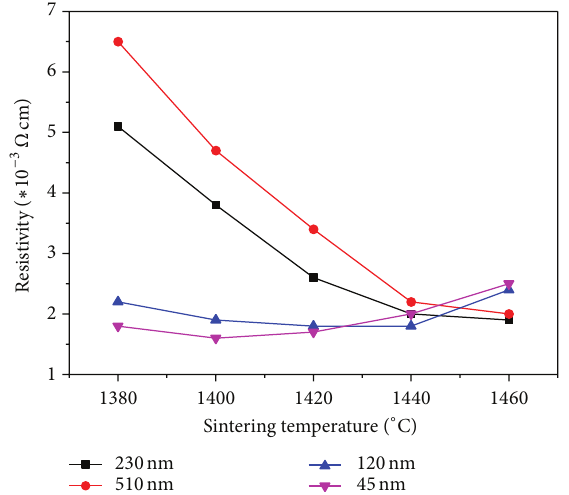
Figure 5: Resistivity of the AZO targets sintered at temperatures of 1380, 1400, 1420, 1440, and 1460 ∘